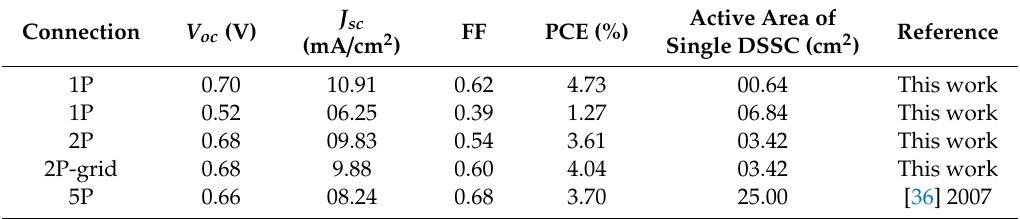
Table 3. Photovoltaic property of DSSCs with different parallel (P) connections.